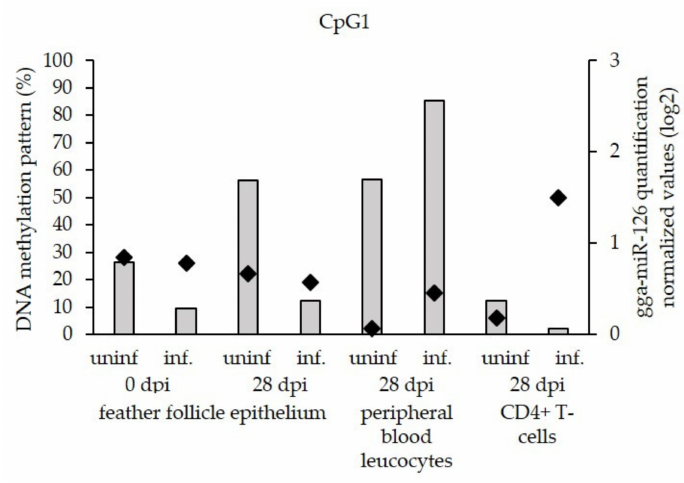
Figure 4. Correlation between the miR-126 quantification (right Y-axis, gray histograms) and the DNA methylation pattern in CpG1 (left Y-axis, black diamonds). The DNA methylation percentage is one of the yellow frame regions of Figure 3. The X-axis represents the different samples used: feather follicle epithelium at 0 and 28 days dpi, as well as peripheral blood leucocytes and CD4+ T lymphocytes from either uninfected (uninf.) or infected (inf.) birds at 28